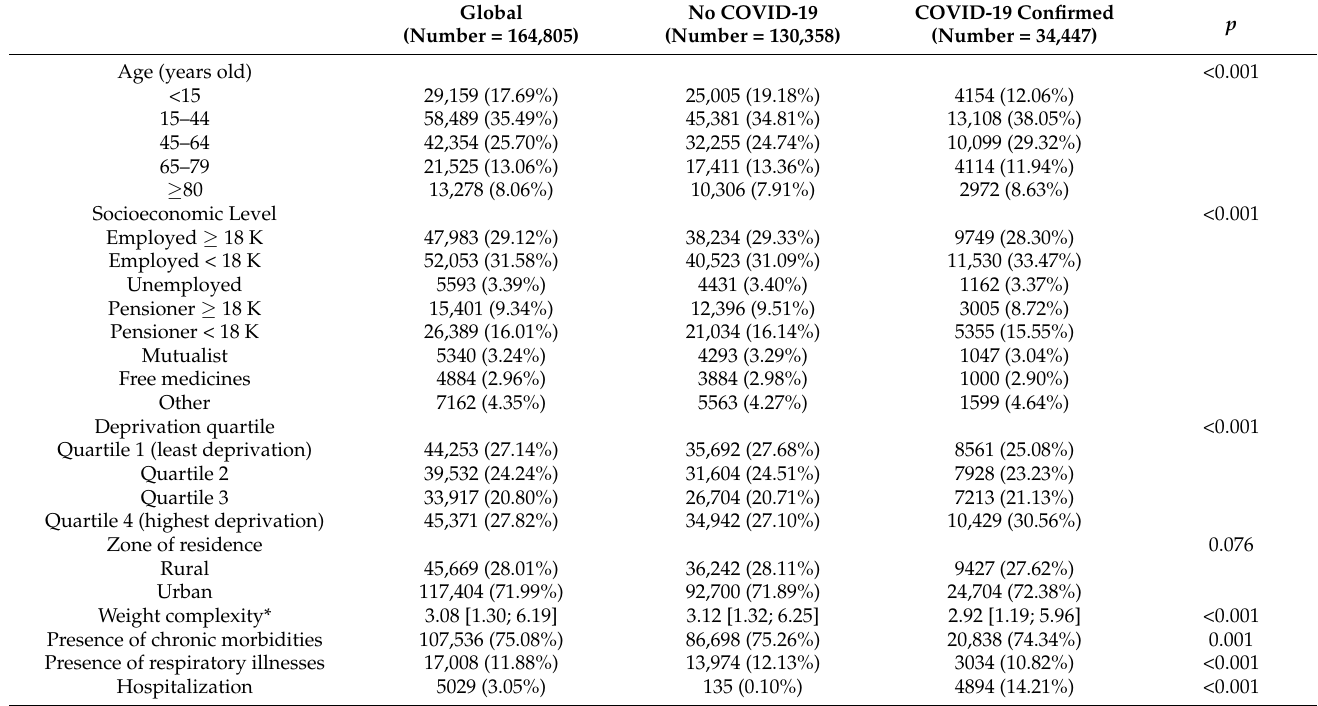
Table A3. Sociodemographic and morbidity description of men tested for COVID-19 for the whole period analyzed. Global No COVID-19 (Number = 164,805) (Number = 130,358)